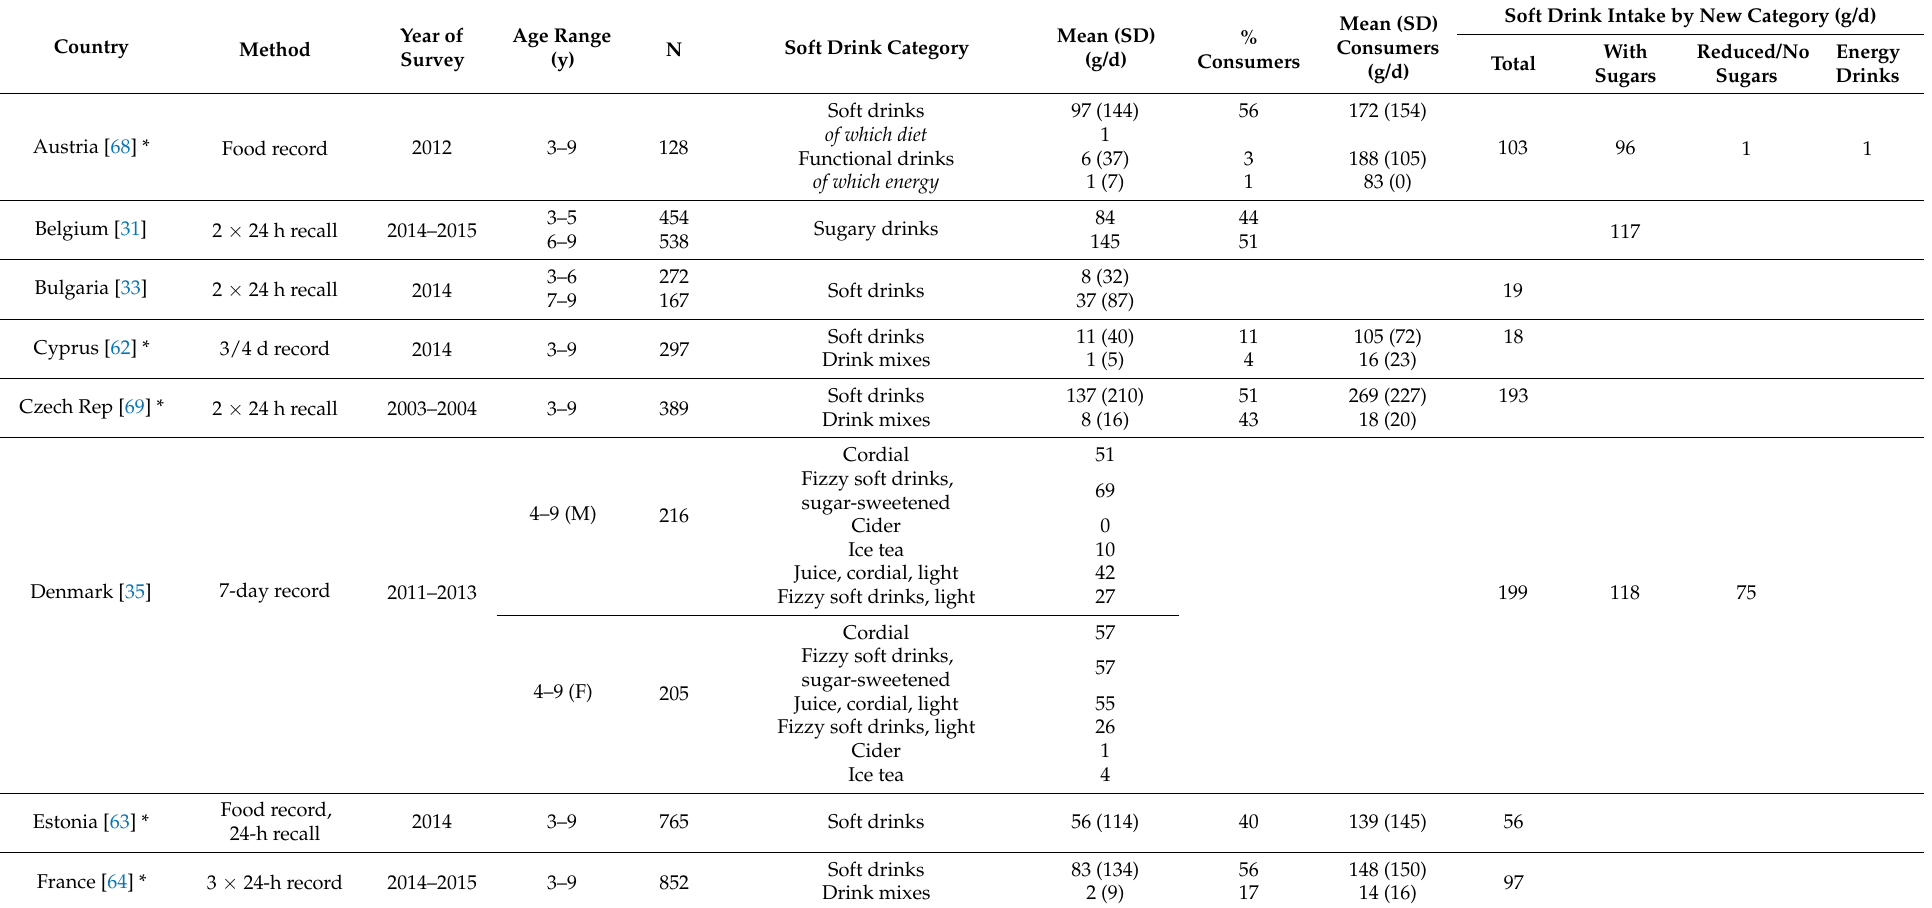
Table 3. Soft drink intake in children (~4–10 y) in the WHO European Region, as reported in National Dietary Surveys and by new